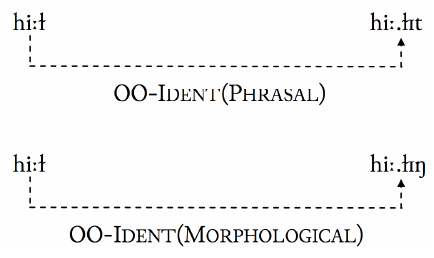
Figure 1: From Bermúdez-Otero